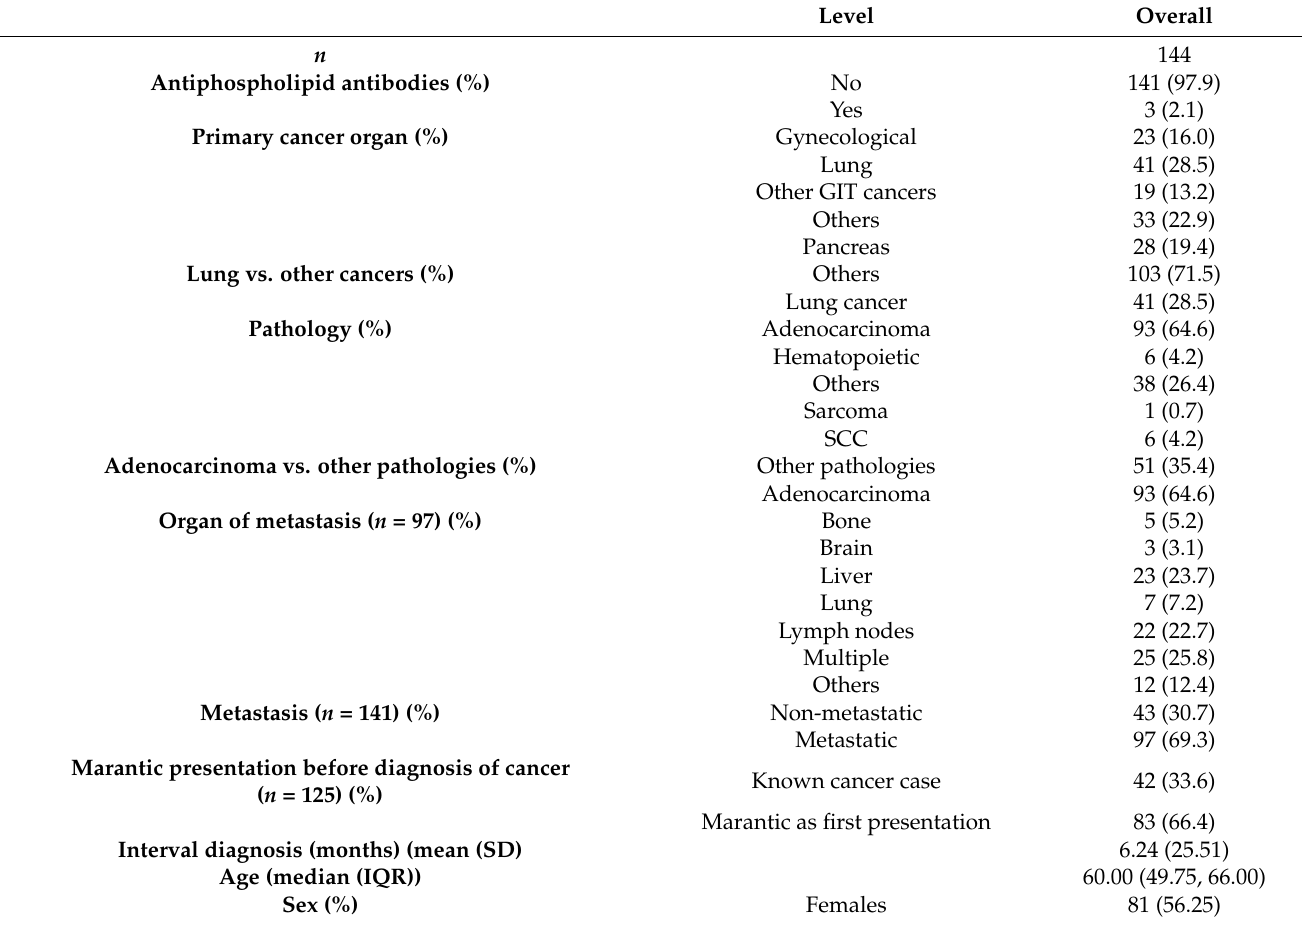
Table 1. Criteria of included